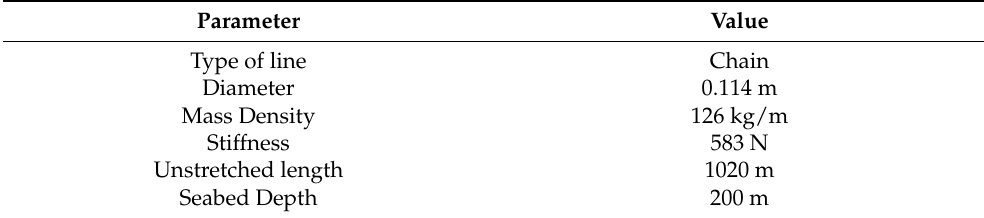
Figure 13. Nautilus moorings layout. Table 4. Moorings layout main